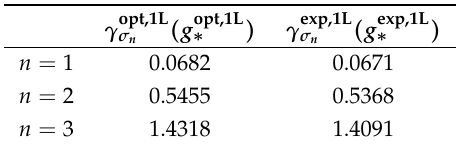
Table 1. Fixed-point values of γ σ for d = 4. The first and second column report the results obtained n via the optimized and the exponential cutoff,